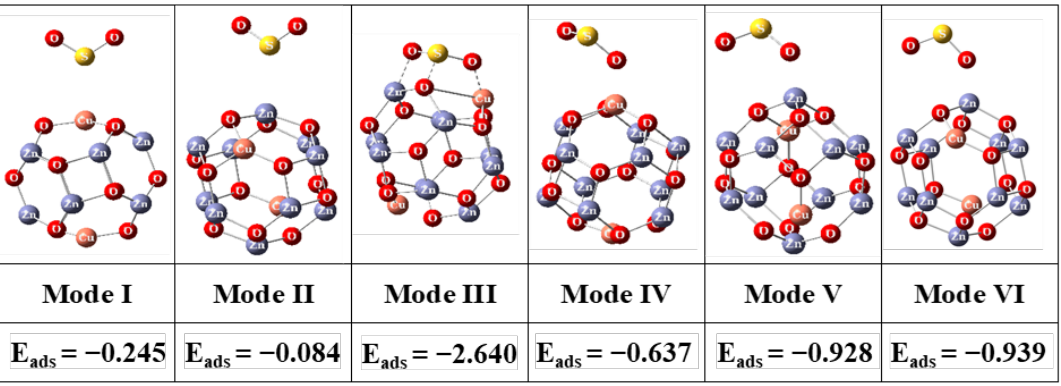
Figure 5. The optimized complexes with adsorption energies in eV of H 2 S/Cu 2 Zn 10 O 12 complexes.